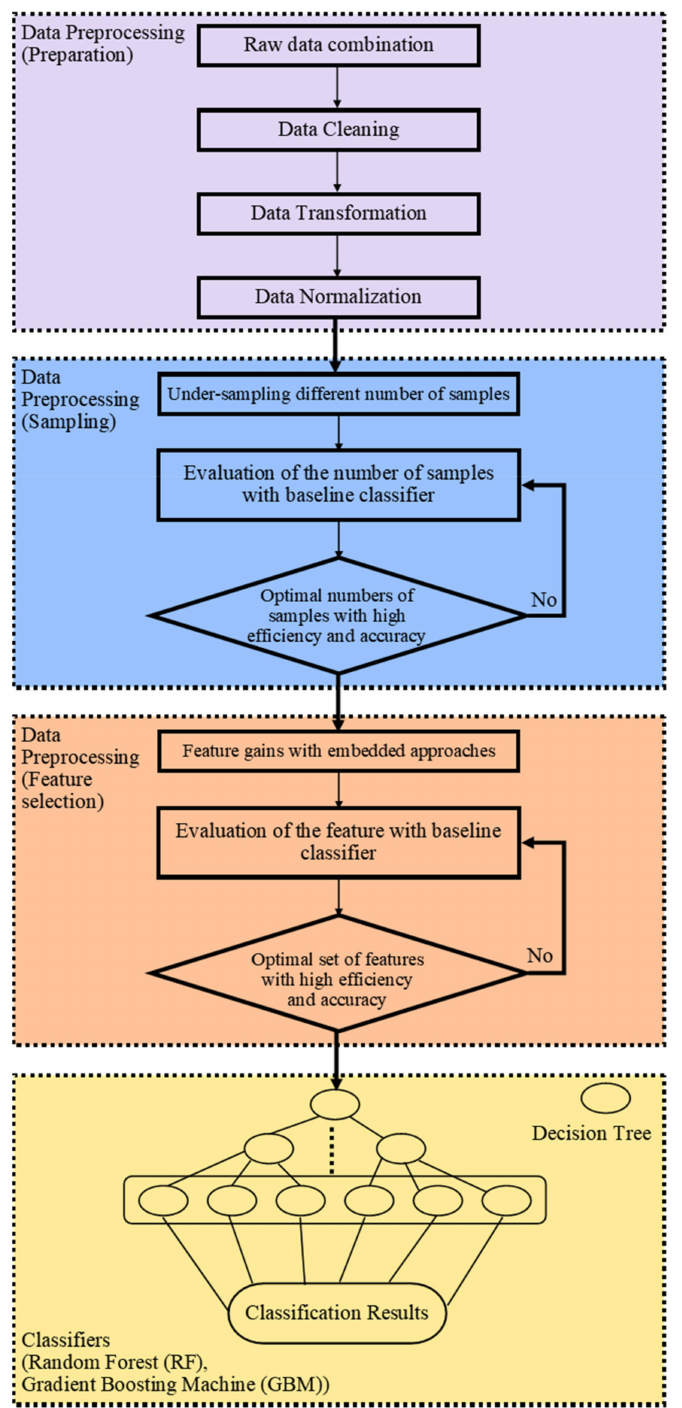
Figure 1. Proposed